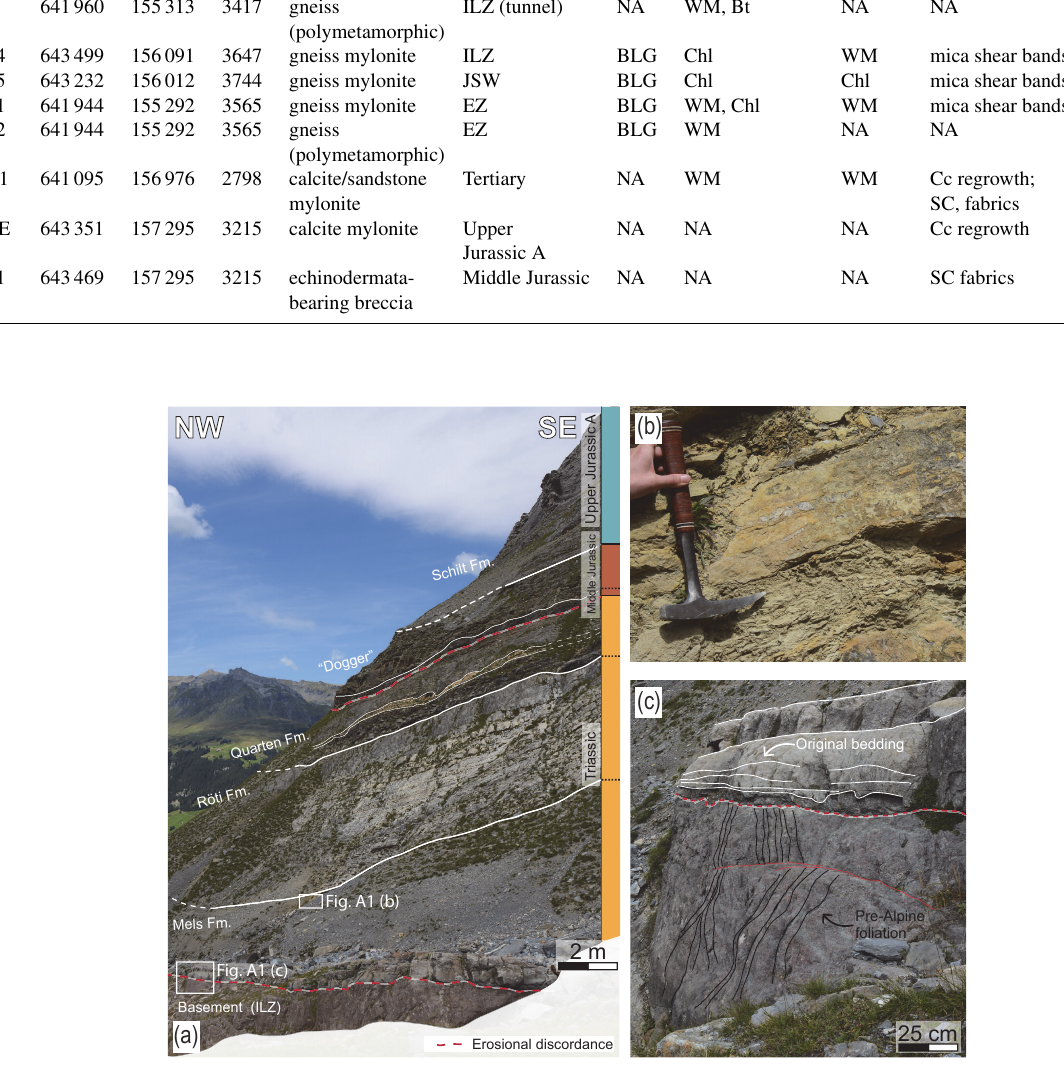
Figure A1. Undeformed basal stratigraphic section of the sedimentary cover of the ILZ in the Rottal (RT).